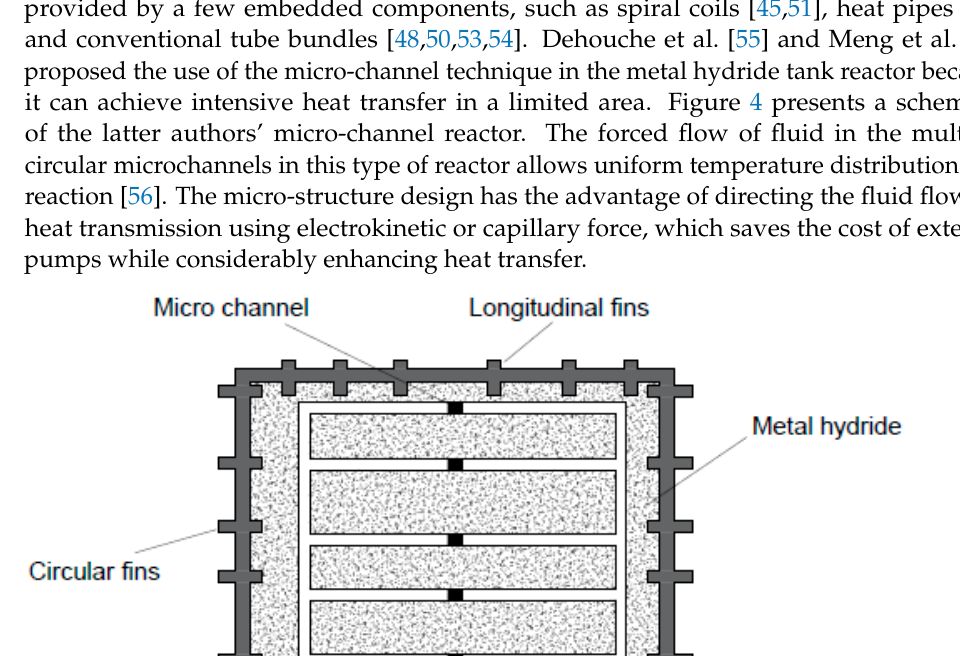
Figure 4. Schematic of micro-channel reactor. The tank reactor’s most important characteristic is its high capacity. As a result, it is recommended for environments where more metal hydride materials are required to achieve the appropriate output. To meet the requirements for excellent performance, the number and placement of heat and mass transmission devices must be carefully evaluated as the bed dimension increases [53,54]. Fortunately, the highly developed computational